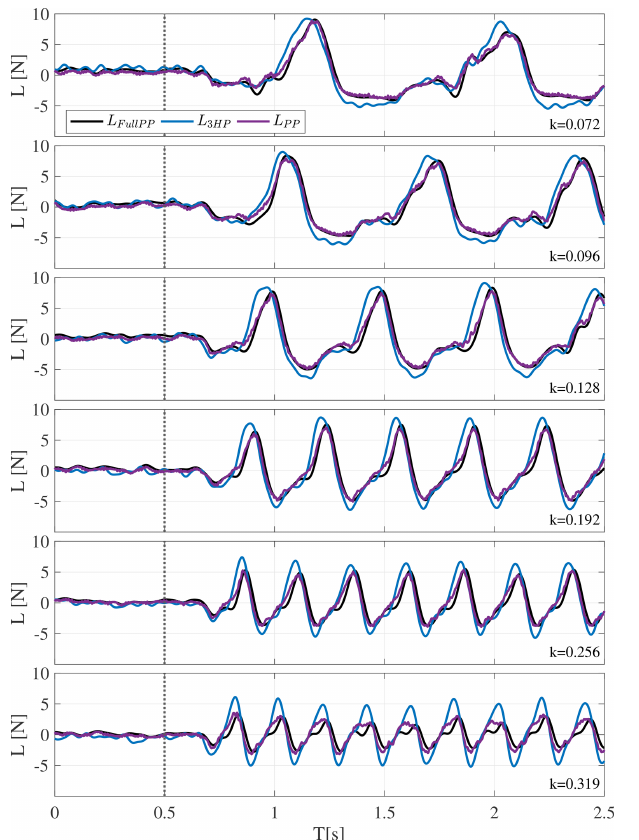
Figure 16. Comparison of the lift estimate to full pressure distribu- tion at ¯ α = 5 ◦ . Fixed